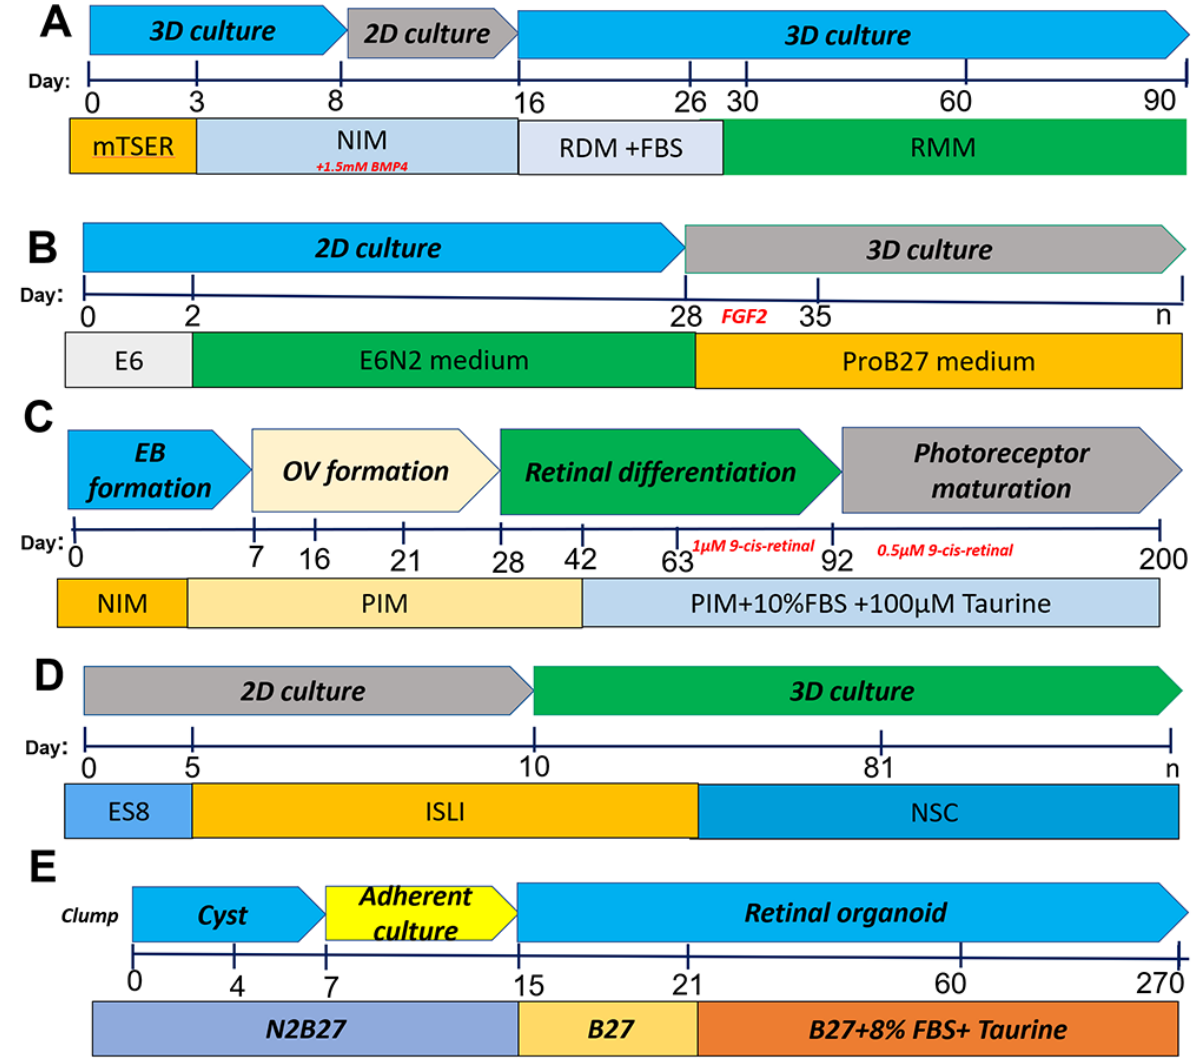
Figure 2. Summary of various protocols ( A – E ) for retinal organoid differentiation from human induced pluripotent stem cells. ( A ). The protocol of using 3D–2D–3D culture in retinal differentiation medium. Chichagova et al., 2017 [43]. ( B ). The protocol of using 2D–3D culture in ProB27 medium. Reichman et al., 2019 [44], ( C ) Long-term retinal differentiation with embryoid bodies, which shows the photoreceptor maturation. Kaya et al., 2019 [45]. ( D ) The protocol of using 2D–3D culture in